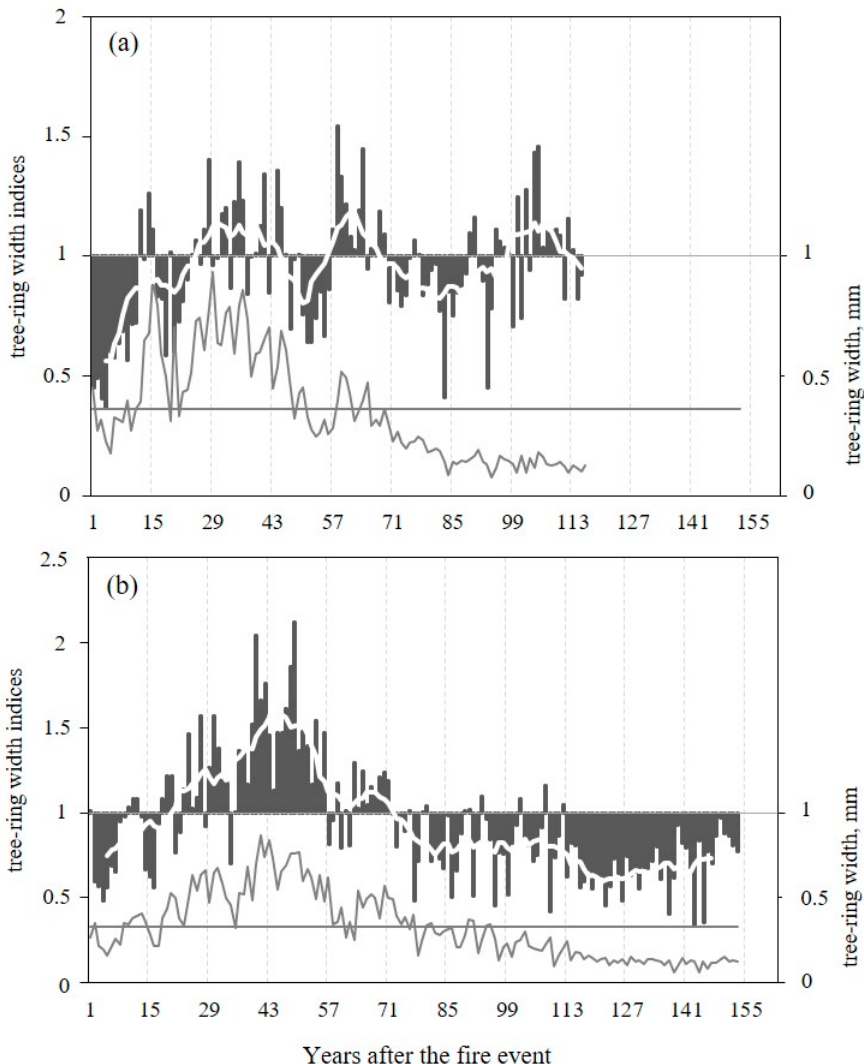
Figure 2. Dynamics of tree-ring width (line) and tree-ring width indices (column) for two sites from data (between 1896 and 2011 and between 1852 and 2005) after the detected fires DS—1896 ( a ) and WS—1852 ( b ), respectively, are shown. The white lines (based on the smoothening by an 11-years running means) indicate the periods with indices values > 1. The horizontal lines show the level of average values of TRW after fires (0.36 mm on DS and 0.33 mm on WS).